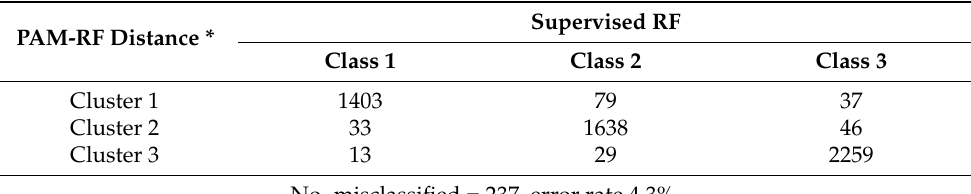
Table 2. Results from supervised random forest validation procedure to check the predictive accu- racy of the used model.